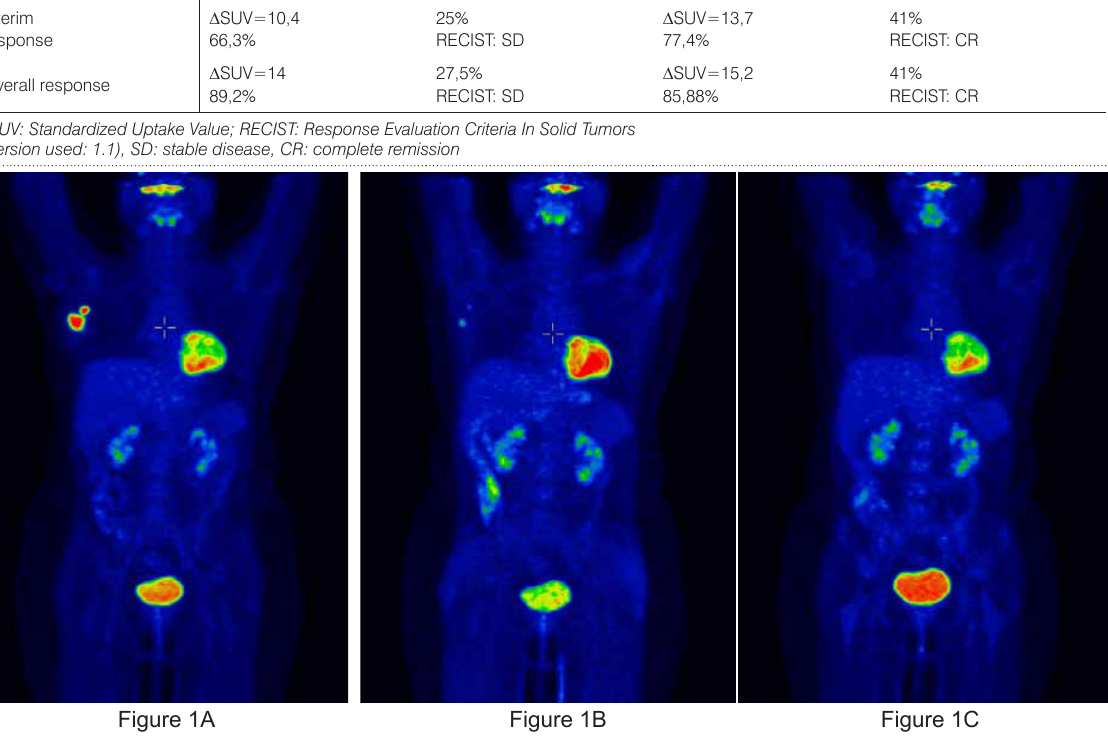
Figure 1 A-C. Staging (Fig.1A), interim (Fig.1B) and restaging (Fig.1C) FDG-PET-CT investigations; MIP (Maximum Intensity Projection) PET images. On the staging image (Fig.1C) the metabolically active tumor in the right breast and one metastatic lymph node were visible (arrow). The interim images (after C01) showed metabolic regression in both regions (Fig.1B), and on the restaging scans (after C06) the primary tumor showed metabolic complete remission, with slight residual uptake in the axillary region (Fig.